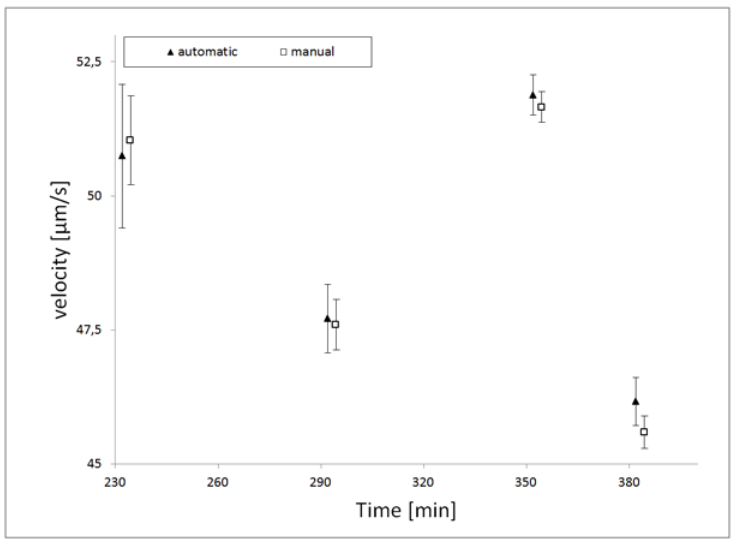
Fig 7. Validation of automatic image analysis. The validation of automatic image analysis by manual analysis of the image series on the four significant sampling points of interest (before diauxic shift, diauxic shift, after diauxic shift, start of sporulation) during fermentation 1. The error bars represent the Standard Error of the Mean of the bacterial velocity. The number of determined velocity vectors per sample are 232: n man = 354, n aut = 210; 292: n man = 1150, n aut = 673; 352: n 352man = 3818, n aut = 2820; 382: n man = 2600, n aut =